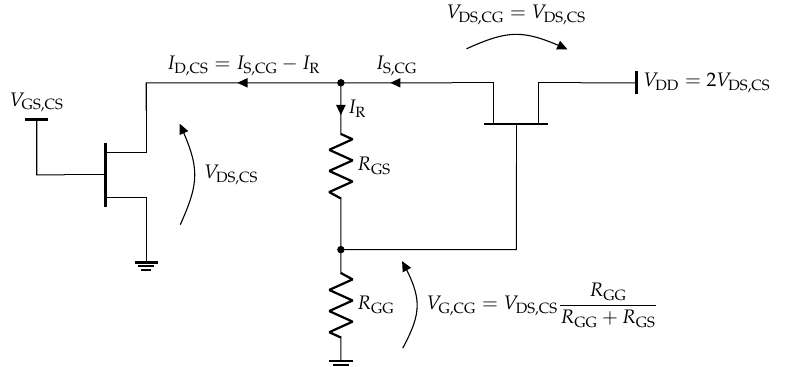
Figure 13. Adopted self-bias network (stacked cell in DC operation).